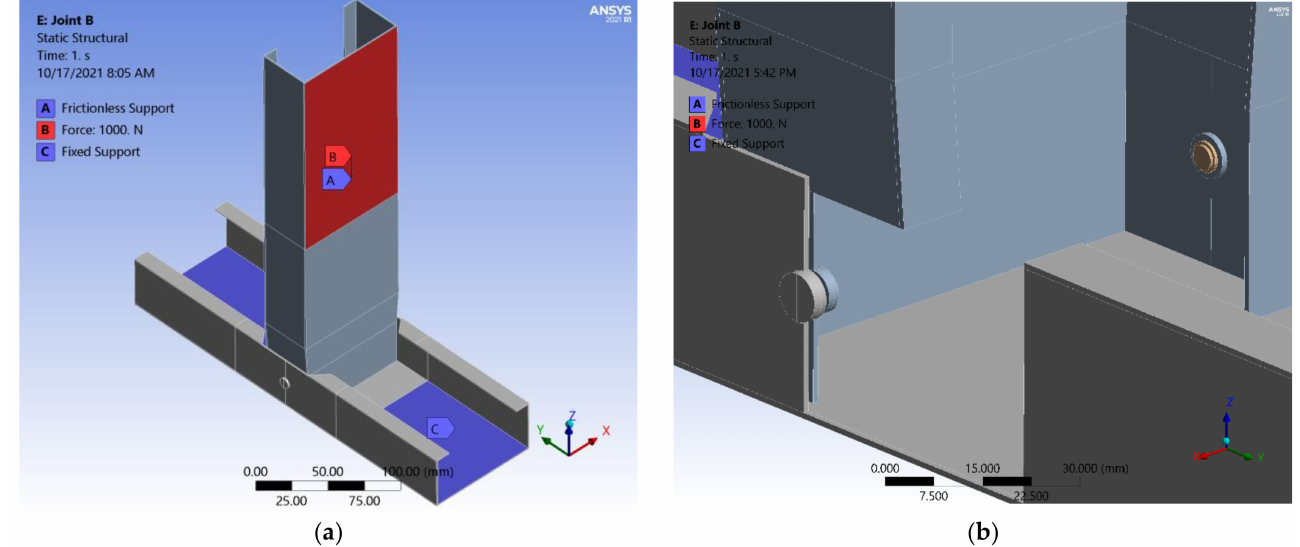
Figure 27. Geometry joint B: ( a ) overall; ( b ) detail.